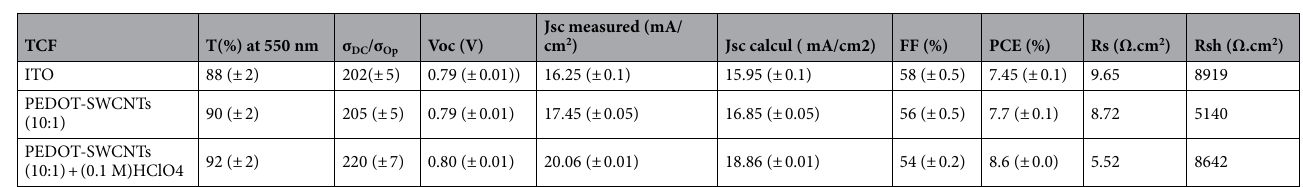
Table 1. Summary of the photovoltaic performances of all devices with the PET/TCF/PTB7:PC71BM/VOx- PEDOT-PSS/Ag structure and an area of 0.8 cm 2 .